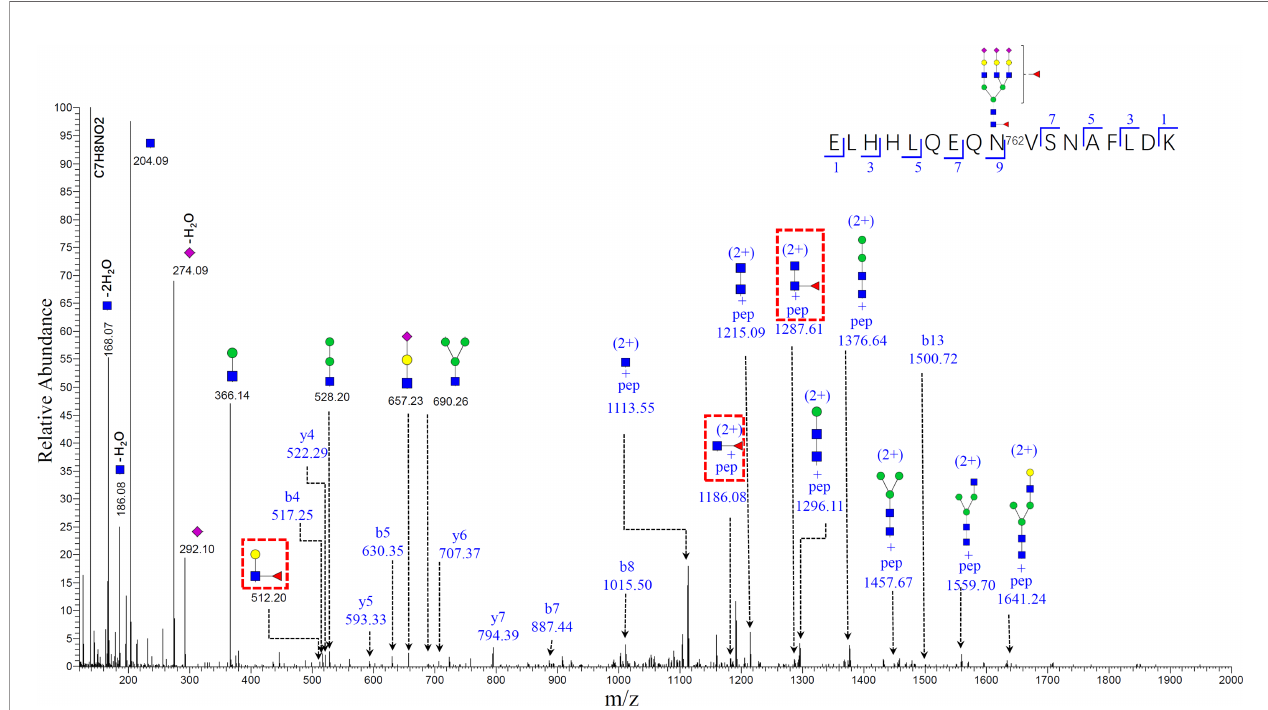
FIGURE 6 | Representative MS/MS spectrum of N-glycopeptide of ELHHLQEQN 756 VSNAFLDK with the glycan HexNAc(5)Hex(6)Fuc(2)NeuAc(3). The oxonium ions, glycosidic fragments and b/y fragments from the peptide backbone were well characterized. Speci fi c diagnostic fragment ion (HexNac+Gal+Fuc) at m/z 512.20 con fi rmed the outer-arm fucosylation, and ions (pep+HexNac+Fuc) at m/z 1186.08 and (pep+2HexNac+Fuc) at m/z 1287.61 (marked by red dashed rectangles) con fi rmed the core-fucosylation. (The symbols used in the structural formulas: blue square = HexNAc; green circle = Man; yellow circle = Gal; purple diamond =